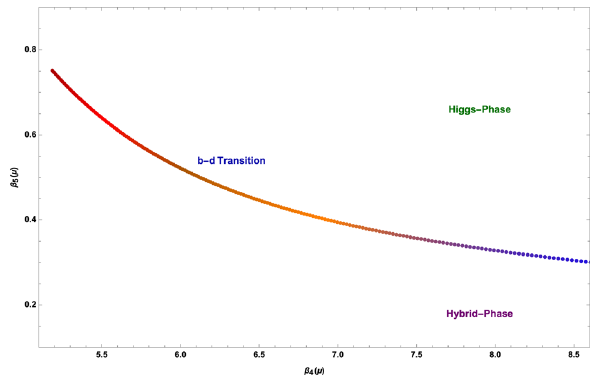
Fig. 7 The perturbative phase diagram. The featuring phase transi- tion is weak first order and bulk-driven (b-d Transition) separating the Higgs from the hybrid phase. The phase line is constructed by pairs of (β ,β ) obtained at the cut-off scale μ ∗ by means of the matching 4 ∗ 5 ∗ procedure described in the text, while its colour code reflects that the cut-off scale increases from the IR (left, redder dots) to the UV (right, bluer